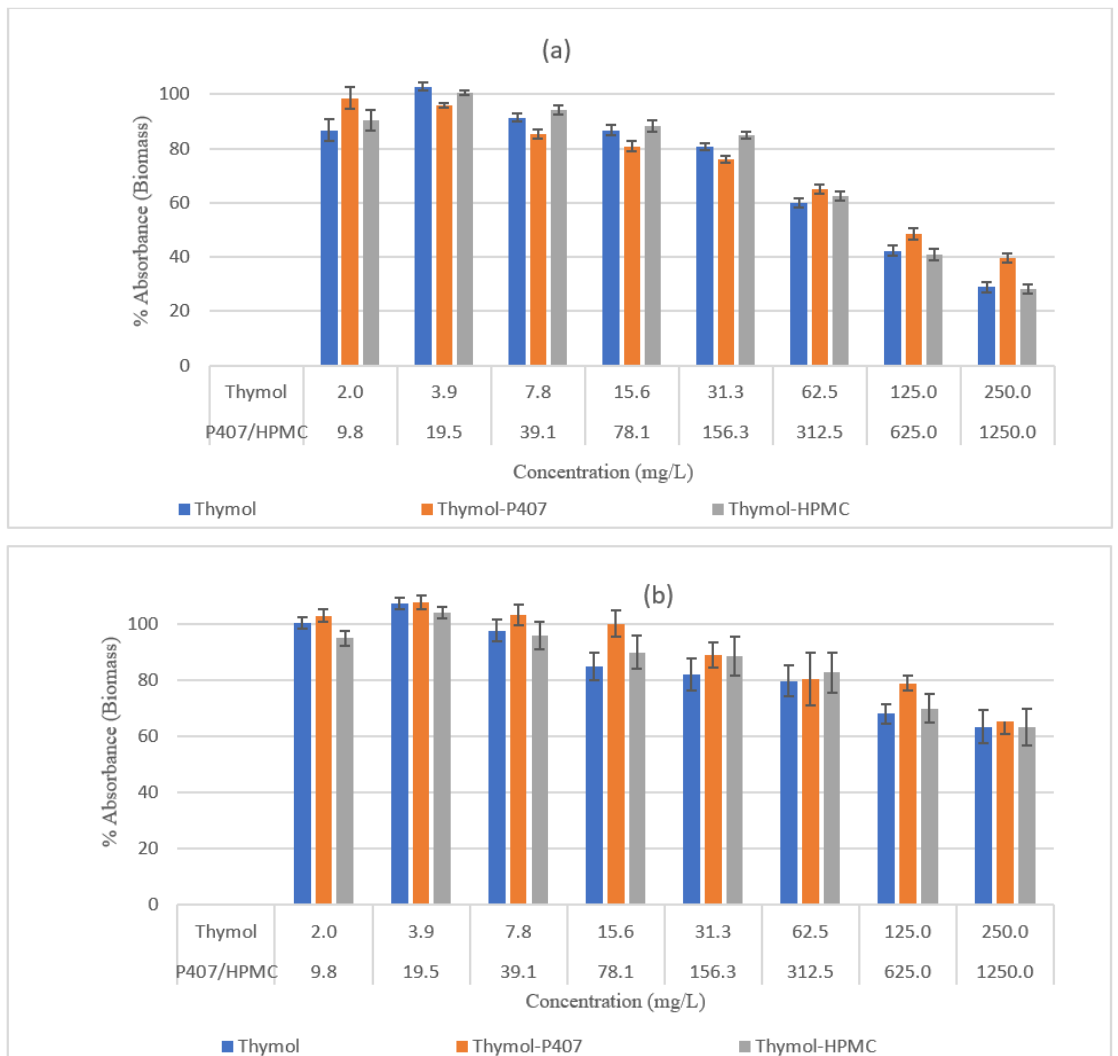
Figure 3. Effect of thymol on the biomass of C. albicans biofilm ( a ) 4 h, ( b ) 24 h, ( n = 8) for 2 h at 37 °C. Each point represents the mean percentage ± SE.